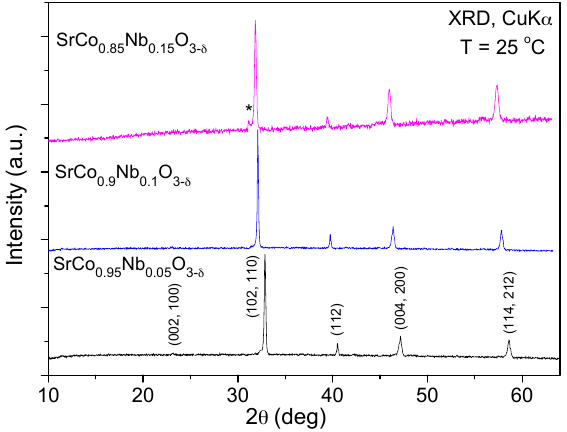
Figure 1. X-ray diffraction (XRD) patterns (Cu K α ) for SrCo 1 − x Nb x O 3 − δ ( x = 0.05, 0.10, and 0.15) indexed in the tetragonal P4 / mmm space group. x = 0.05 data are taken from ref. [18], reprinted and adapted from [18], with permission from © 2014 Elsevier.